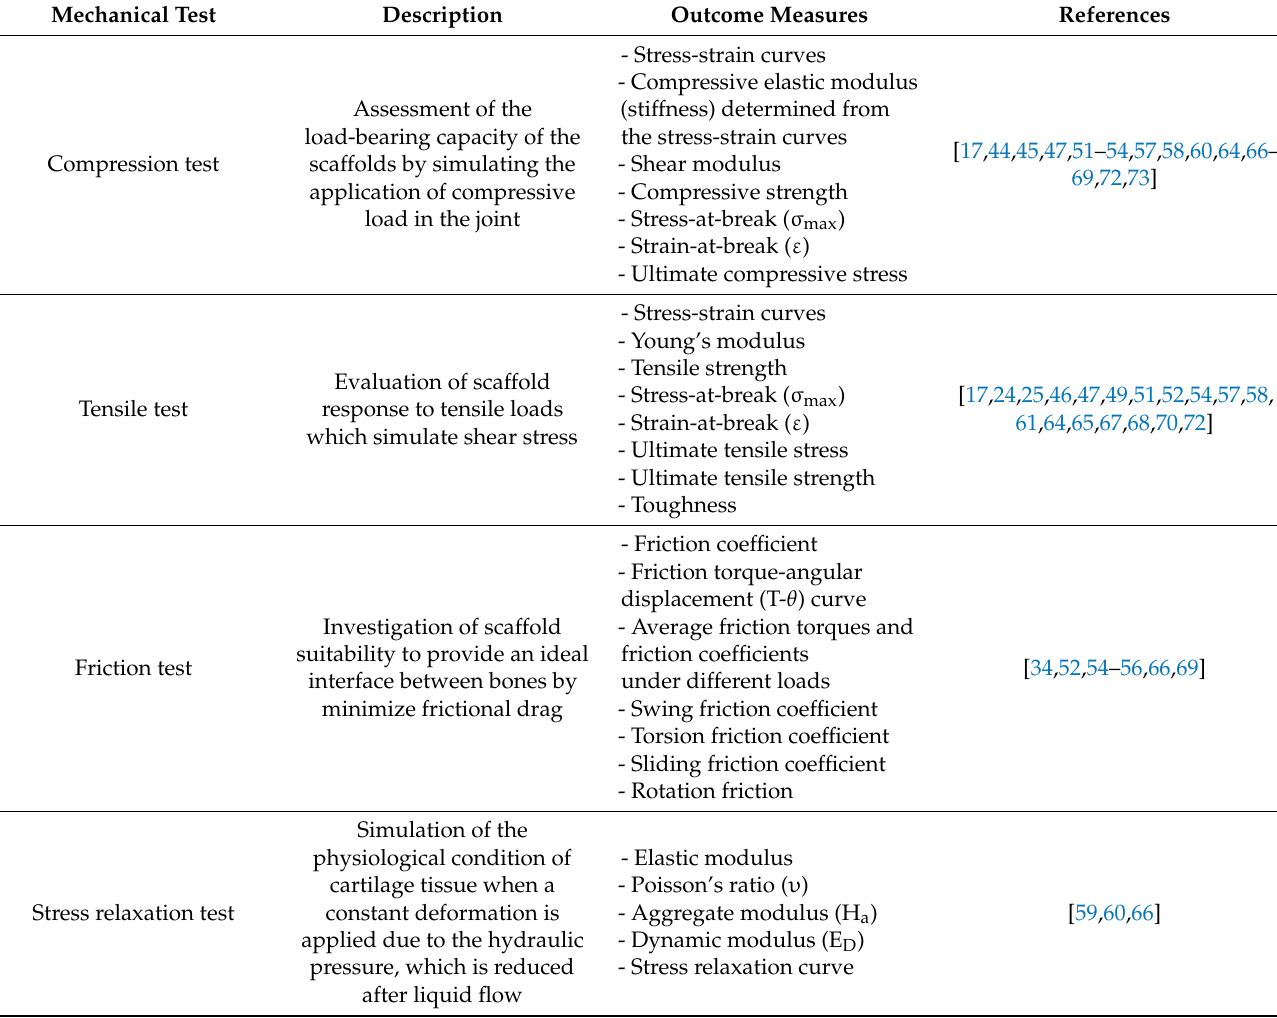
Table 3. Mechanical tests performed on PVA-based composite scaffolds designed for cartilage TE. Mechanical Test Description Outcome